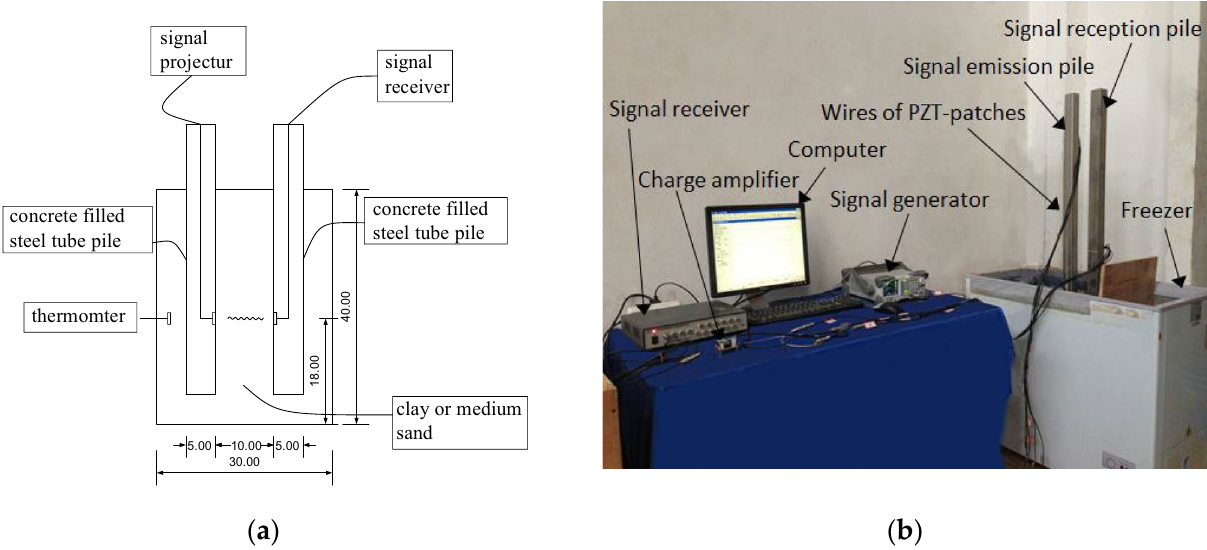
Figure 1. Schematic diagram of experimental apparatus. ( a ) Sample device. ( b ) Layout of experimental equipment.